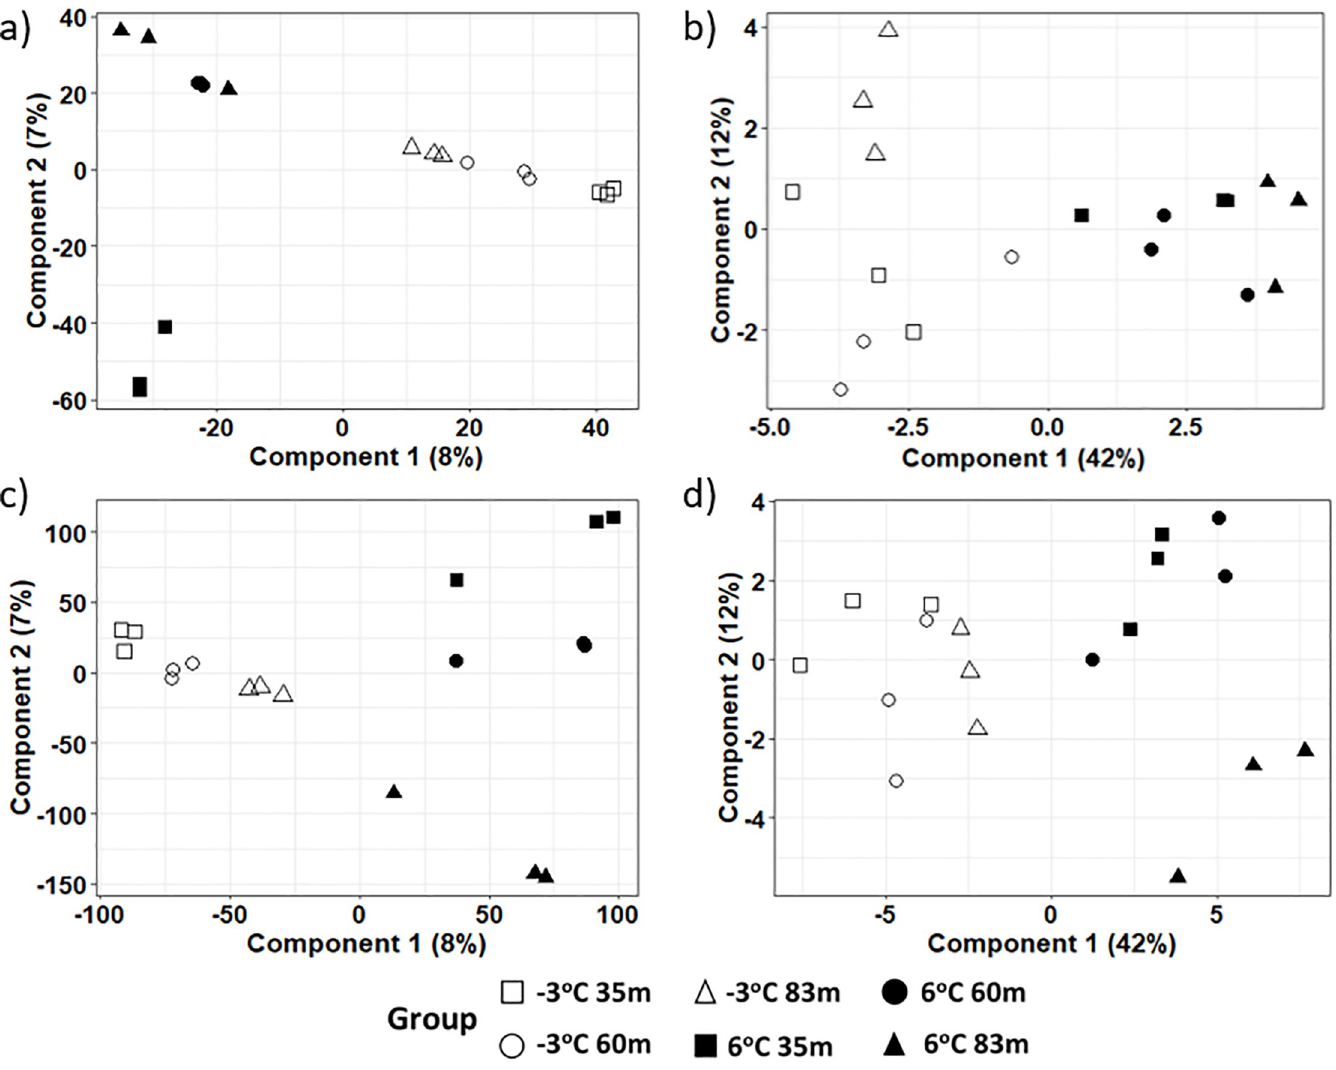
Fig 5. A 2-D plot of the first two components of the PLS-DA scores calculated from dataset of the metabolites in permafrost microbial cells at the various locations and thawed from -3 o C to 6 o C. Figures a and b are the PLS-DA scores from the unfiltered and filtered datasets, respectively, in the ESI+ mode and figures c and d are the PLS-DA scores from the unfiltered and filtered datasets, respectively, in the ESI-